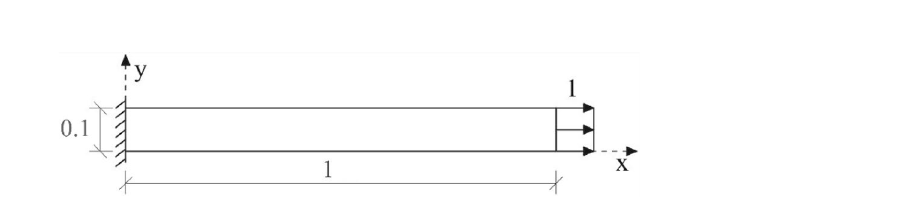
Figure 11. Representation of the problem solved in example